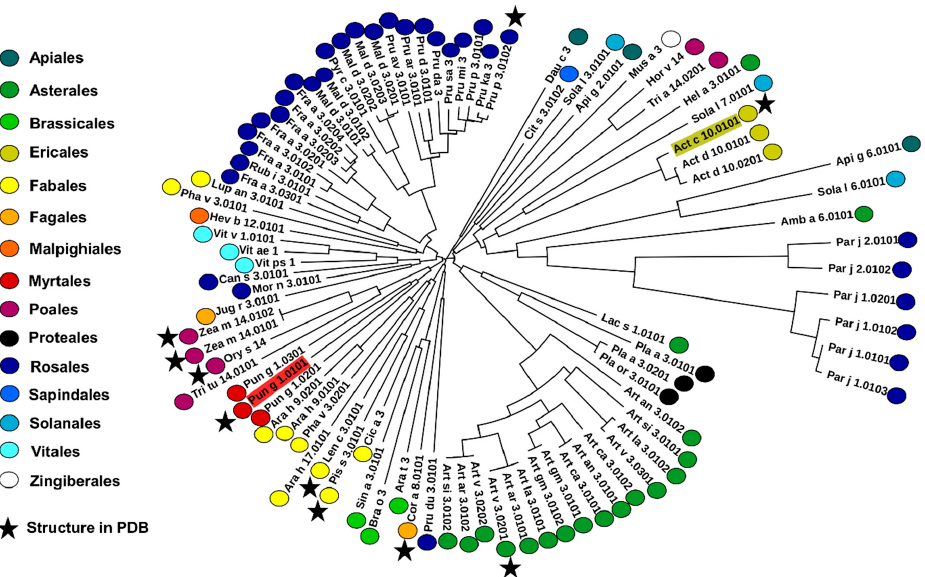
Figure 4. Phylogenetic tree constructed with sequences of nsLTPs that are reported as allergens. Dots next to proteins’ names indicate orders from which particular allergens originate. Stars mark proteins that have their structures determined and reported to the Protein Data Bank [51].